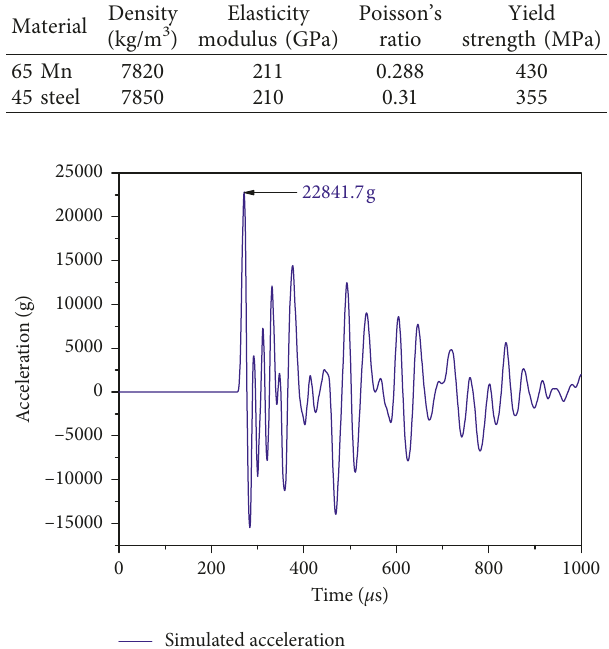
Figure 15: Simulation result of the stress wave verification experiment.